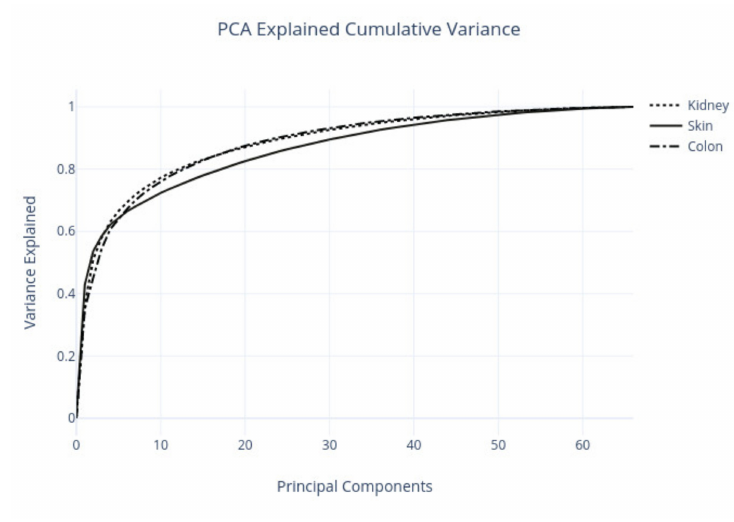
Figure 6. Explained cumulative variance by principal components.